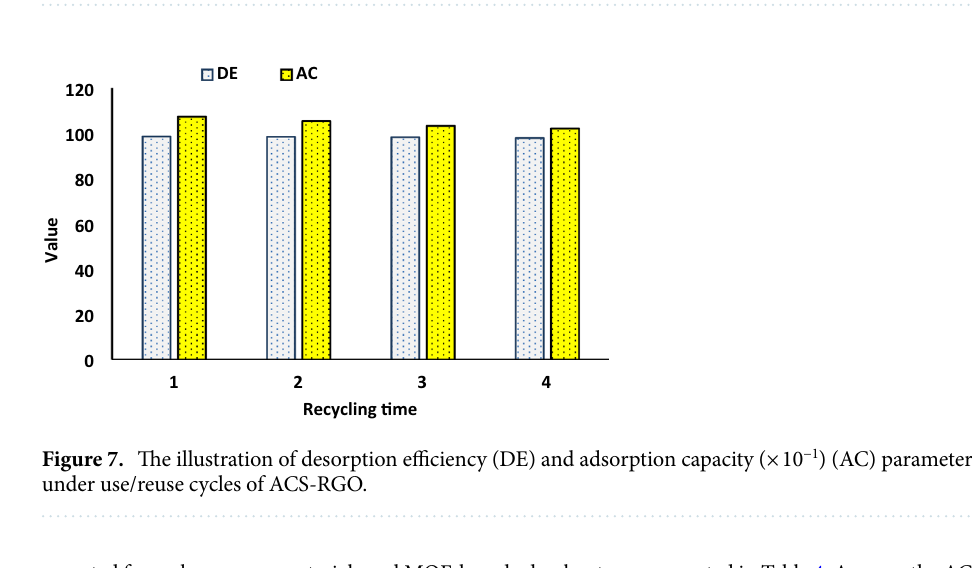
Figure 7 present the result of four series of regeneration/reuse of ACS- RGO. Dilute hydrochloric acid was used as the eluting agent to desorb MG. As seen in the Fig. 7, after four cycles